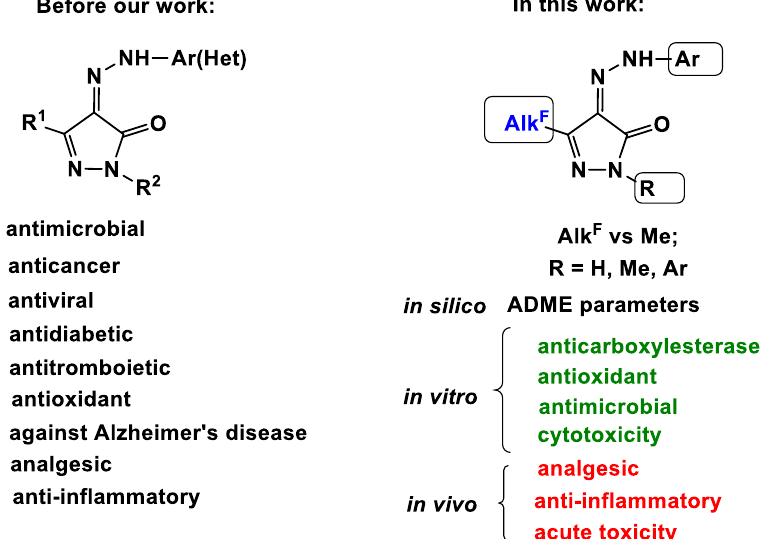
Figure 1. Pharmacological potential of 4-arylhydrazinylidenepyrazol-5-one scaffold.